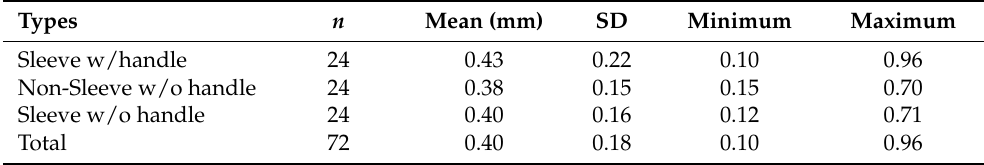
Table 3. Results of descriptive statistics of 3D deviation at coronal in three types of surgical